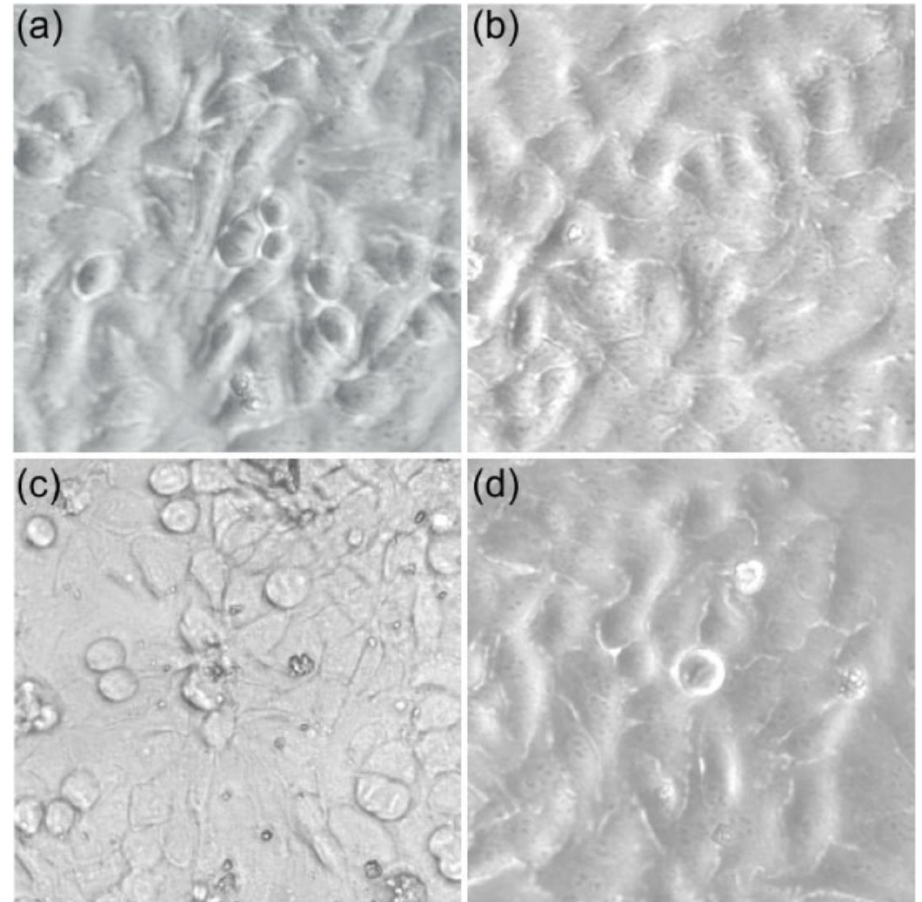
Figure 12. The morphology of the HeLa cells used as control ( a ); incubated with HAp-CTAB nanocomposites in water ( b ), incubated with Pb 2+ contaminated solutions ( c ), and incubated with solutions decontaminated using HAp-CTAB nanocomposites ( d